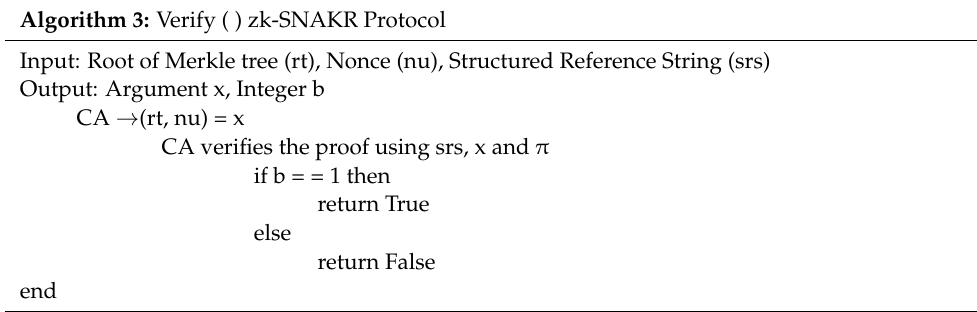
Algorithm 3: Verify ( ) zk-SNAKR Protocol